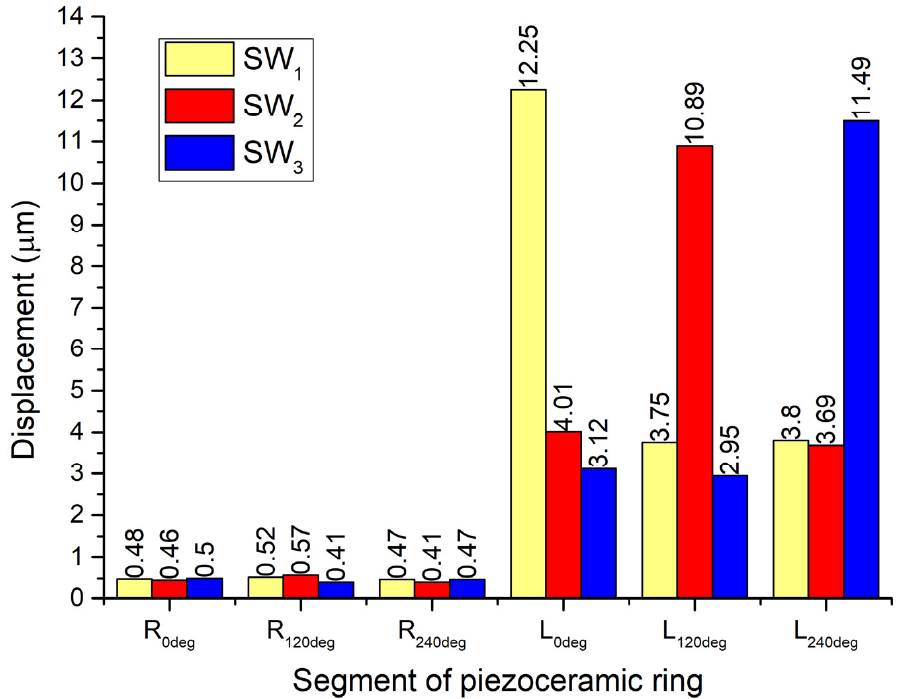
Figure 7. Comparison of displacement amplitudes while segments L 0deg –L 240deg of piezoceramic ring is excited.